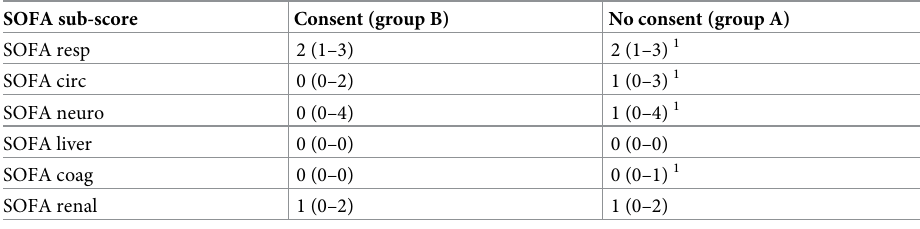
Table 2. SOFA sub-score in the two groups. Data given as median and IQR.